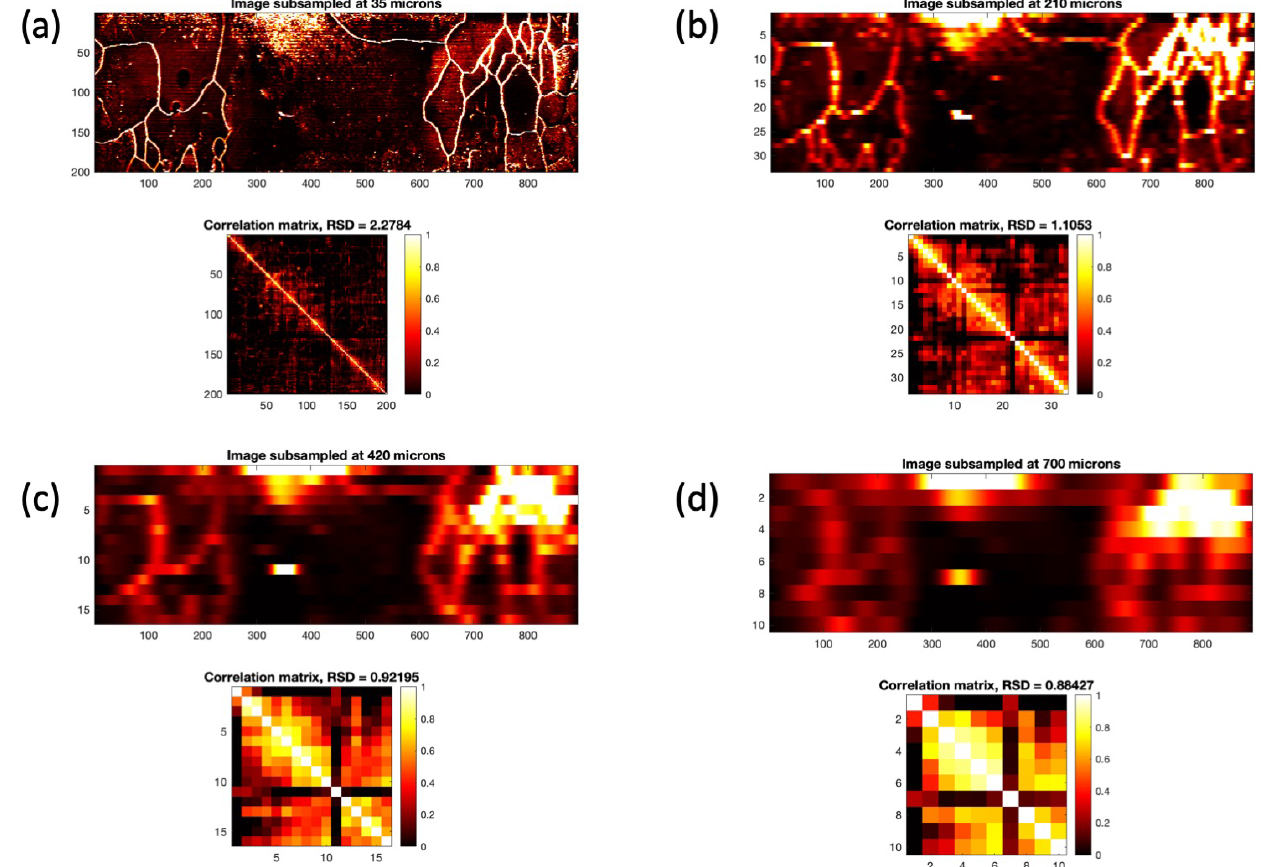
Figure 7. Example images illustrating the effect of decreasing the spatial resolution of the original image (a) in 35µm steps in the vertical and horizontal direction (see text). The correlation matrix is calculated from all lines in the sub-sampled images, together with its relative standard deviation (RSD). Shown here are results for the TD Holocene Na image, at steps of 210, 420 and 700µm, in panels (b–d) , respectively.